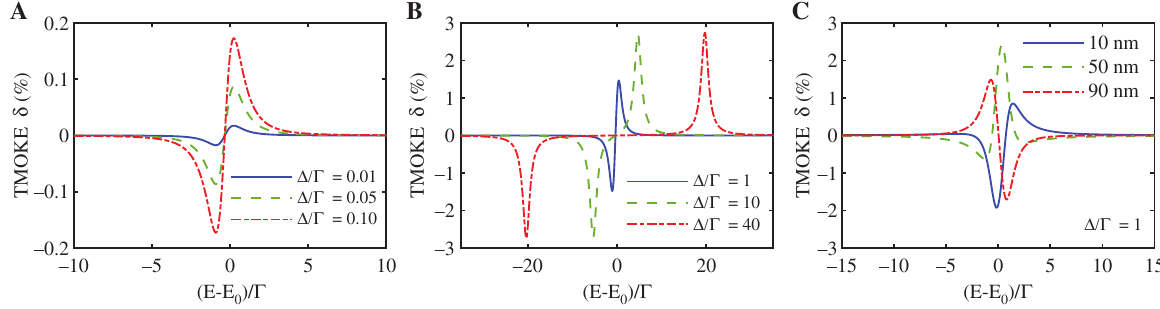
= 0.65 meV, d = 0.65 meV, Δ = 2 meV, E = 1.68 meV, and ε ≈ 8 for cap and epilayer. In all d 0